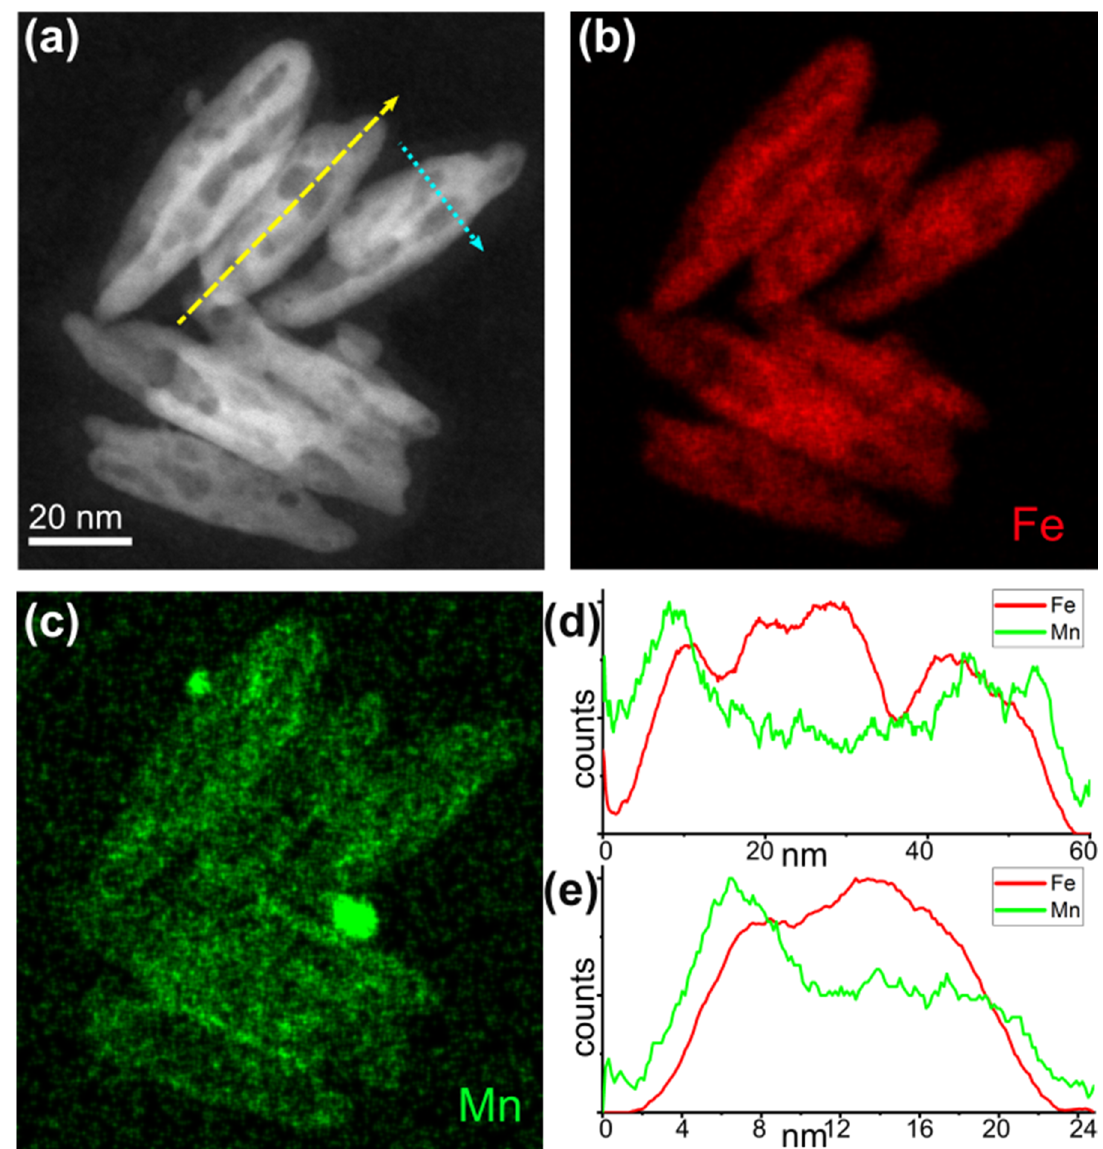
Figure 3. Sample S3_Mn. ( a ) HAADF-STEM image, ( b ) Fe map (red), ( c ) Mn map (green); ( d ) compositional profile of Fe and Mn along the length of the NR (yellow dashed line of panel ( a )), ( e ) compositional profile of Fe and Mn along the width of the NR (cyan dotted line of panel ( a )). S3 and S3_Mn were also investigated by DC magnetometry to study the effect of a high AR, The zero field cooled hysteresis loops recorded at 4 K show the features of S3 and S3_Mn in anisotropic shape on the magnetic features of single crystals of iron oxide (S3) and core/shell systems (S3_Mn). Both samples are still magnetically blocked at room temperature, as shown by Zero-field- cooled/field-cooled (ZFC-FC) curves (Figure 4), which do not display T B and T IRR within the experimental range (Table 2). The sharp peak in magnetization observed at 40 K in the ZFC (zero- field-cooled) and FC (field-cooled) curves of S3_Mn and the corresponding spike observed in the derivative curve (T MAX ) are consistent with the transition of Mn 3 O 4 from a ferrimagnetic to a